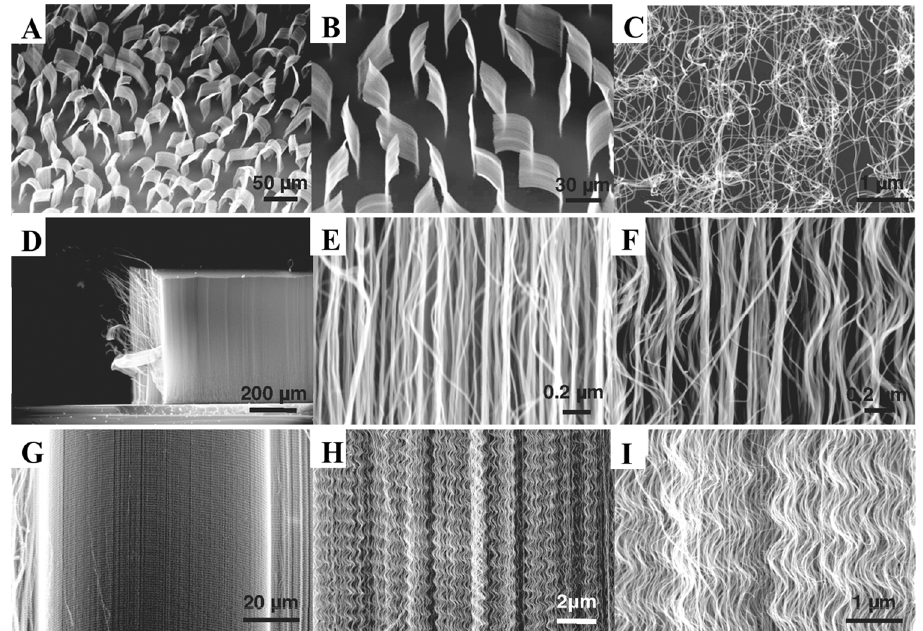
Figure 6. SEM images of different carbon nanotubes (CNT) at different magnifications in thin sheets ( A – D ). Additionally super-aligned, Straight, and waved MWNTs array ( E – I ). Reproduced with permission from Zhang et al. [90] Copyright 2009, Elsevier.